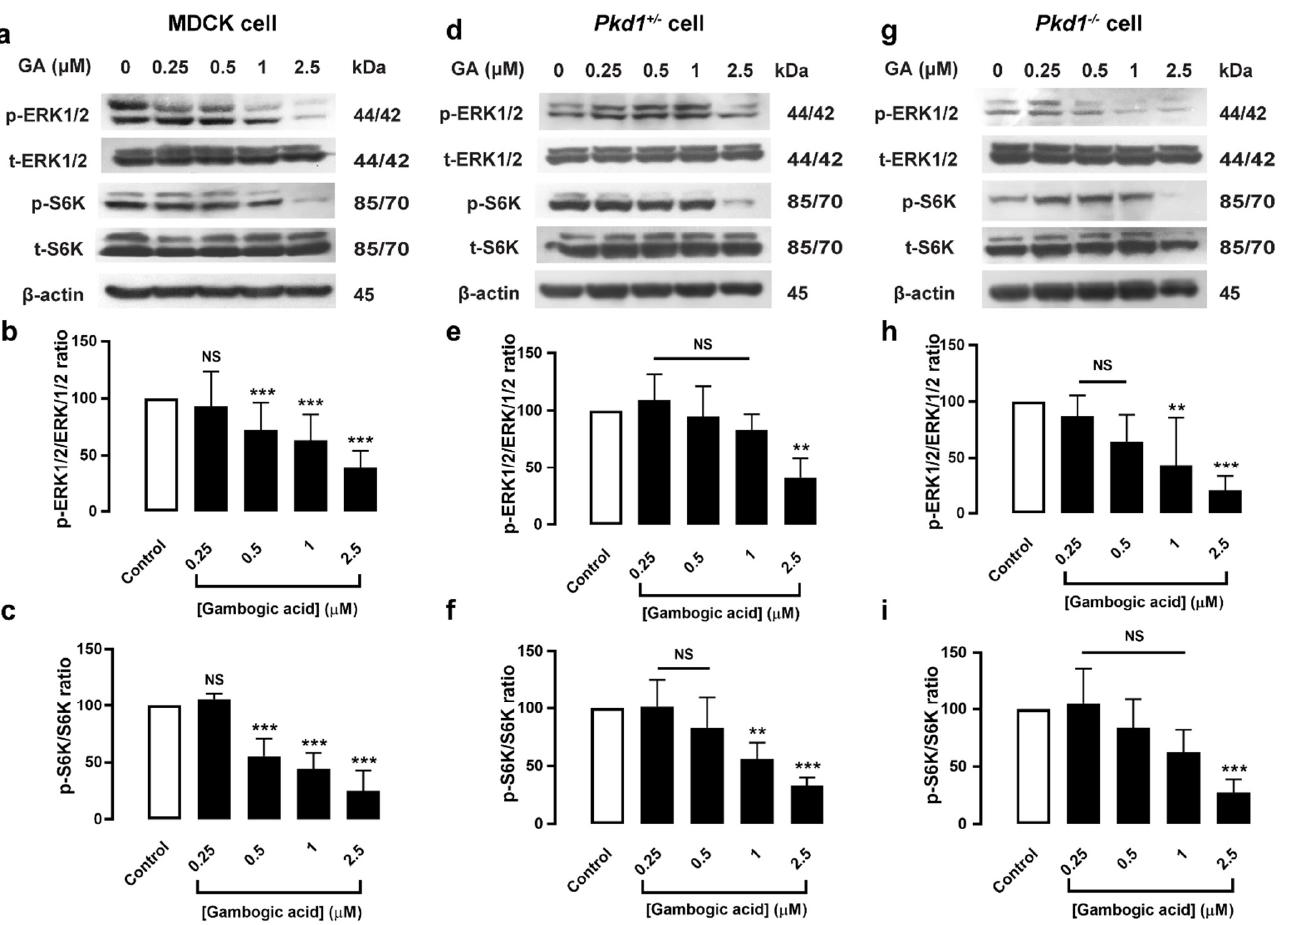
Figure 3. Dose-dependent effect of gambogic acid on ERK1/2 and S6K protein expression in MDCK and Pkd1 mutant cell monolayers. Cells were seeded in a petri-dish (60 × 15 mm) and grown for 24 h. MDCK cells ( a ) Pkd1 − / − cells ( d ), and Pkd1 + / − cells ( g ) were incubated with DMSO (control) or GA at doses of 0.25, 0.5, 1, and 2.5 µ M for 24 h, and blotted with the indicated antibodies. The representative band intensity of protein expression is shown. Densitometric analysis of p-ERK1/2 and p-S6K expression was normalized to β-actin and is shown as a graph of MDCK cells ( b , c ), Pkd1 + / − cells ( e , f ) , and Pkd1 − / − cells ( h , i ), respectively (six independent experiments, mean of % control ± SEM, n = 6, * * p < 0.01, ** * p < 0.001, NS; not significant).